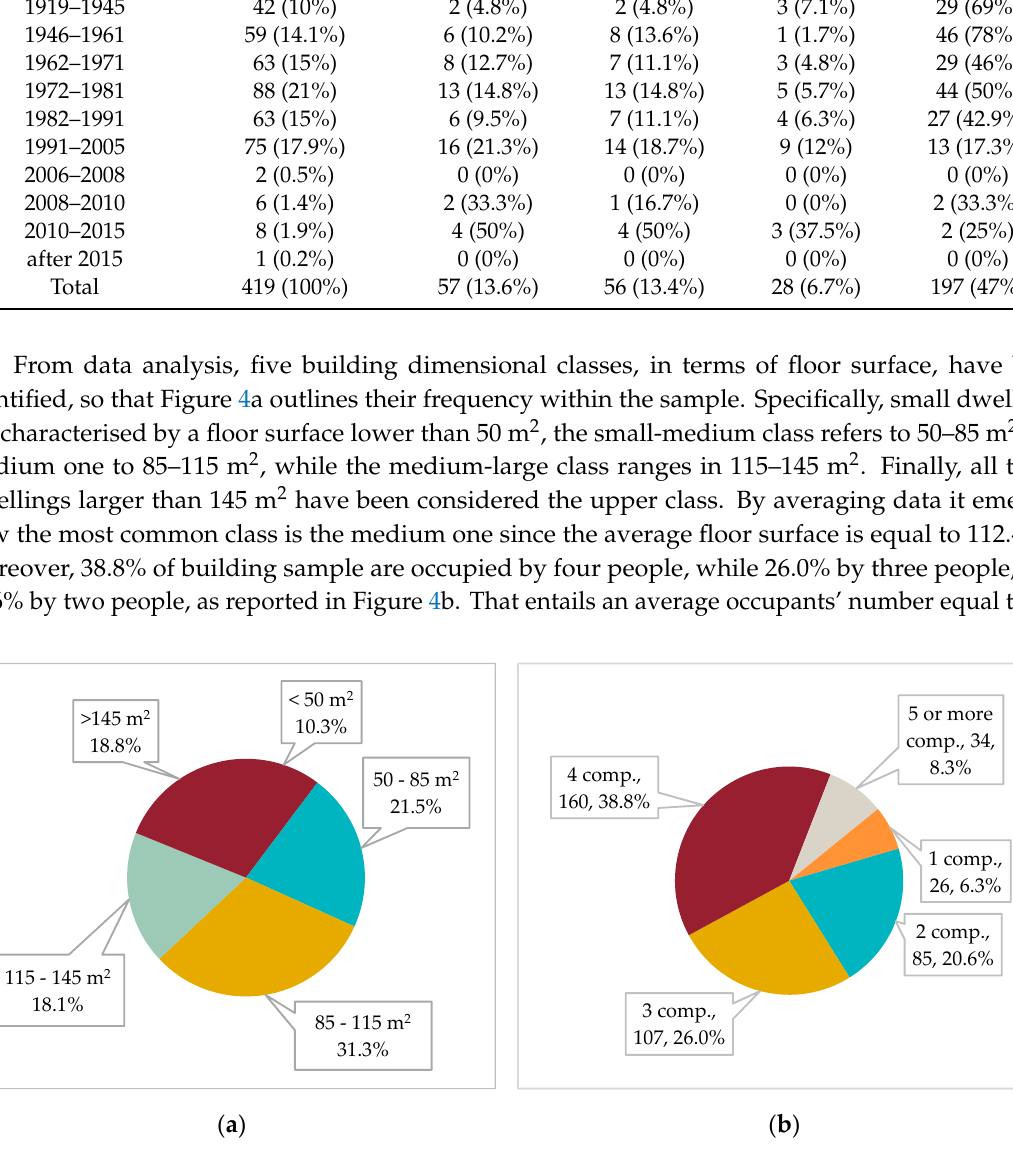
Figure 4. Buildings’ subdivision: ( a ) Household vs. size; ( b ) household vs. family components.